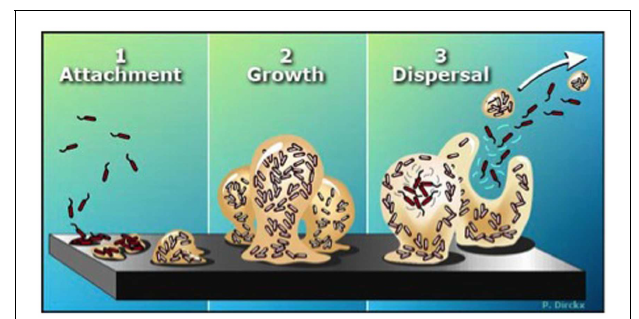
FIGURE 1 | Prevalence of diabetes in the US (red) and the number of lower-limb amputations . Between 15 and 25% of diabetics will develop diabetic foot ulcers in their lifetime. Diabetics often suffer from severe, chronic infections of those ulcers (James et al., 2008;Wolcott et al., 2008, 2010a; Fisher et al., 2010) leading to as many as 70,000 lower-limb amputations per year in the United States (Wolcott et al., 2010a).These